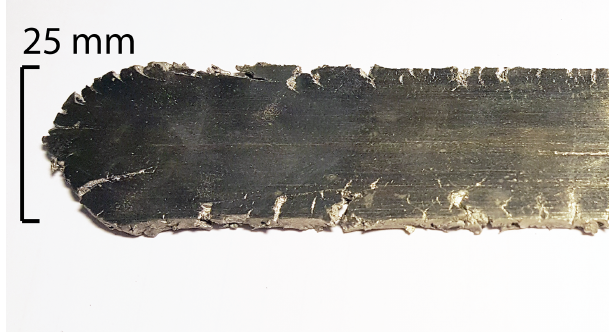
Figure 6. A 3mm thick stock machined from the 6-81 permalloy ingot showing the surface cracking that resulted from an attempt at hot